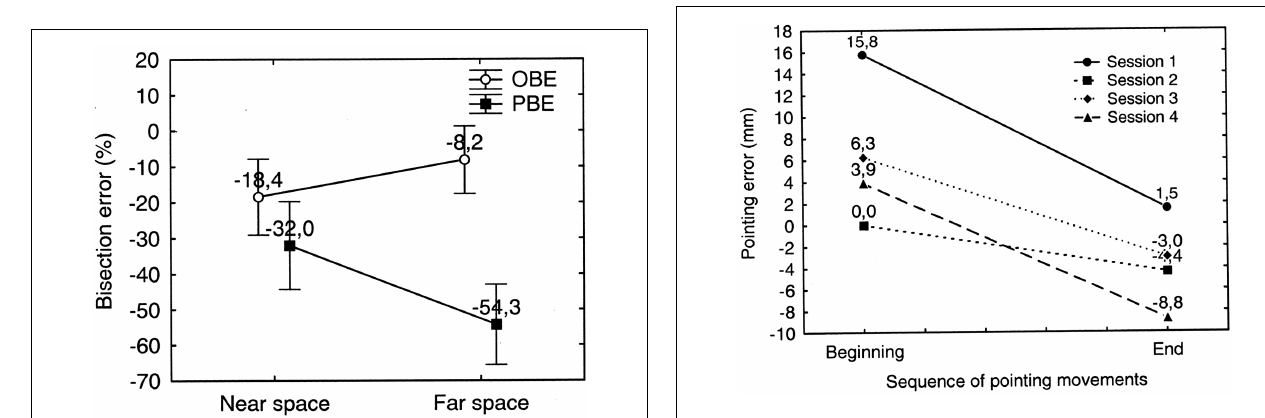
FIGURE 7 | Far and near space bisection errors of patient MR in the walking bisection task . Error bars represent standard errors. Bisection error is expressed as % deviation with respect to half line length. OBE, observed bisection error; PBE, predicted bisection error. Negative and positive values indicate errors to the left and to the right of the objective midline, respectively. Neglect is more severe in far space than in near space: PBE in far space is significantly greater than OBE in near space. See text for details.